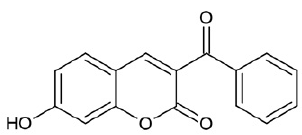
Figure 1: Schematic representation of 3-benzoyl-7-hydroxy cou- marin